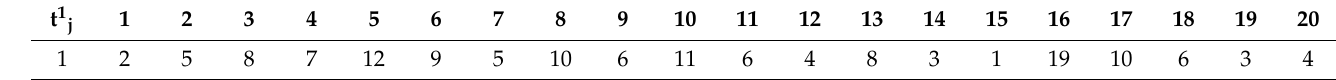
Table 2. The matrix of disassembly operation times of the dryer drum